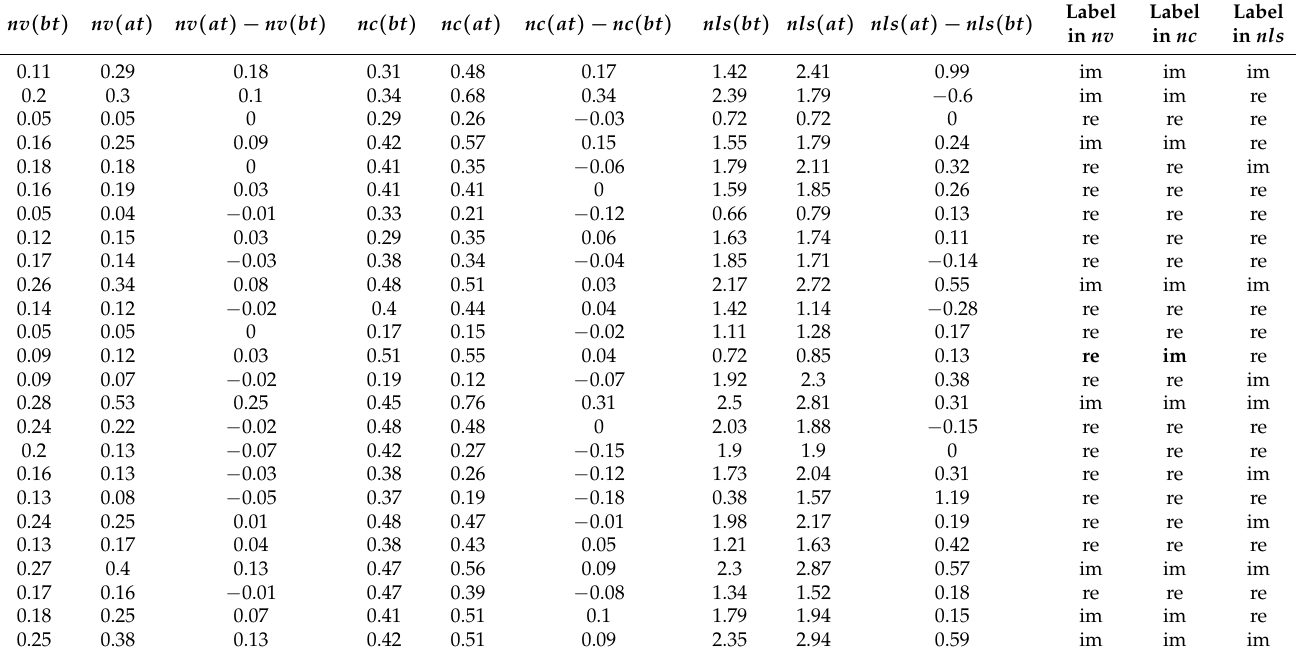
Table 5. Original features, created features, and created class